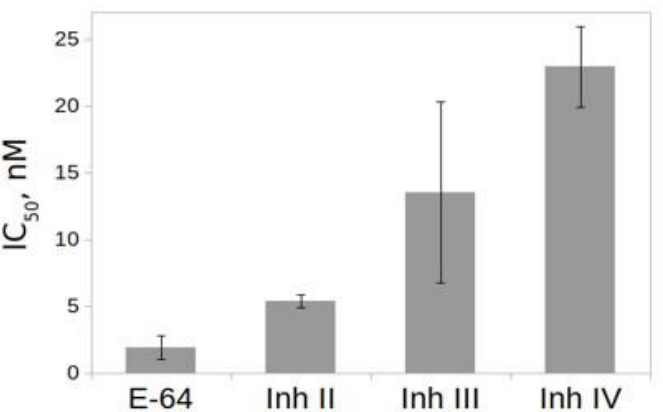
Figure 7. Effect of inhibitors on the activity of rTcCathL1. IC 50 (nM) values were measured with 0.5 mM Glp-Phe-Gln-pNA in 0.1 M UB, pH 5.6 in the presence of 6 mM cysteine. Cathepsin L inhibitors II, III, and IV are named Inh II, III, and IV, respectively.